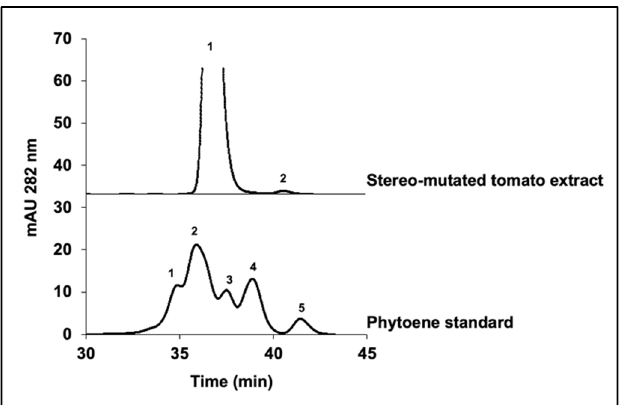
Figure 3. HPLC chromatograms of stereo-mutated phytoene extracts from ripe tomatoes compared to phytoene standard mixture, only showing the region of interest.